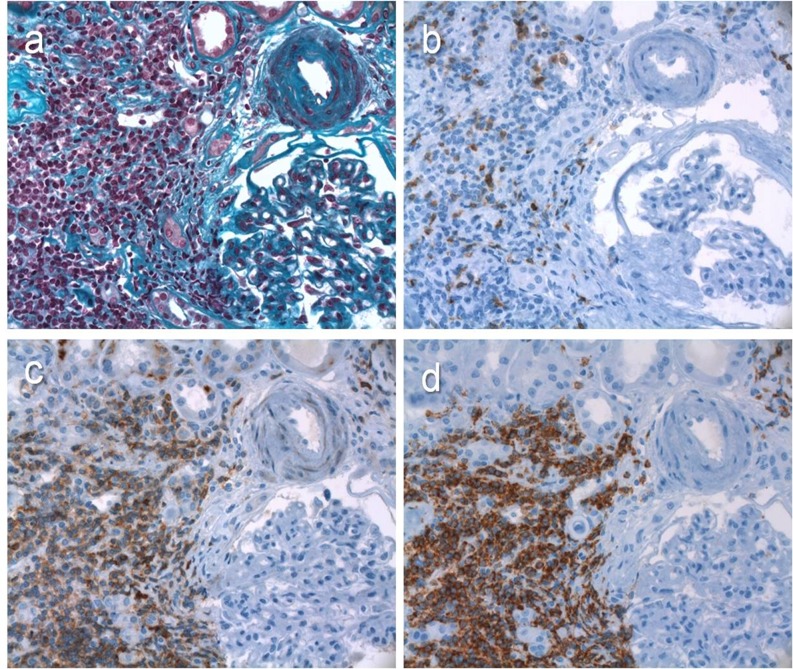
CLL/SLL infiltrate (case 12).(a) Masson trichrome staining. (b) Specific immunostaining to human CD3. (c) Specific immunostaining to human CD5. (d) Specific immunostaining to human CD20. Light microscopy, original magnification, X 40.